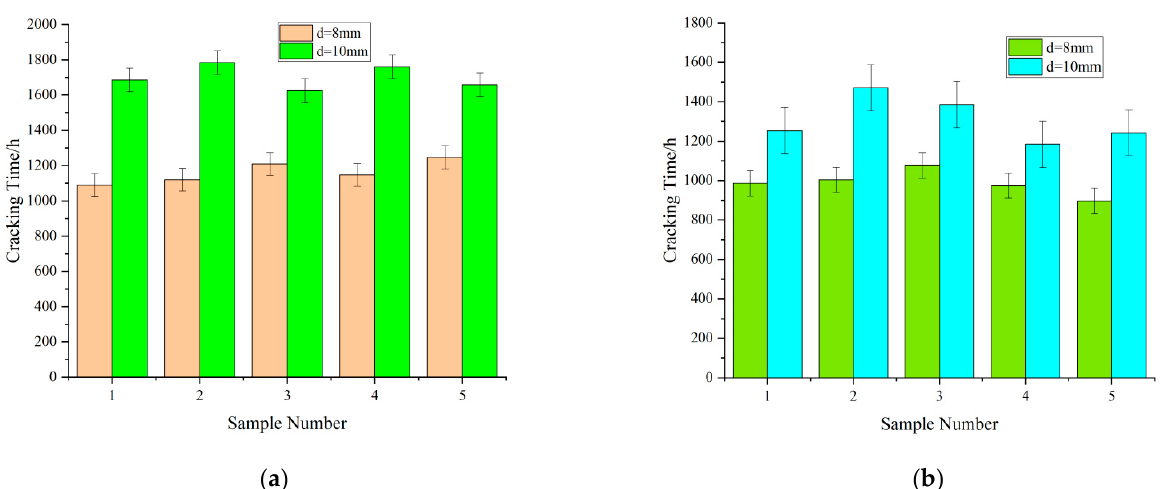
Figure 6. Effect of reinforcement diameter on cracking time. ( a ) Cracking times of samples with different reinforcement diameters d ( c ≈ 15 mm); ( b ) cracking times of samples with different reinforcement diameters d ( c ≈ 12 mm).